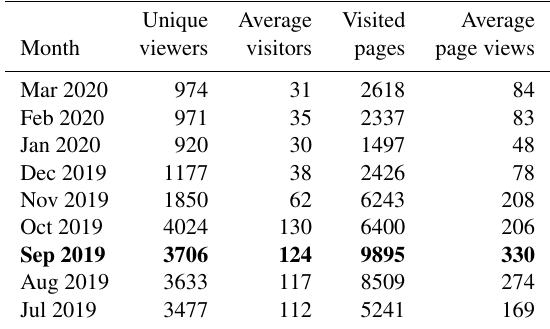
Table 3. Statistics from the Earth and Art blog for the month of September 2019 when the Vesuvius concert took place. These val- ues are indicated in bold to highlight the increased traffic to the blog (http://earthandart.altervista.org, last access: 4 November 2020). Unique Average